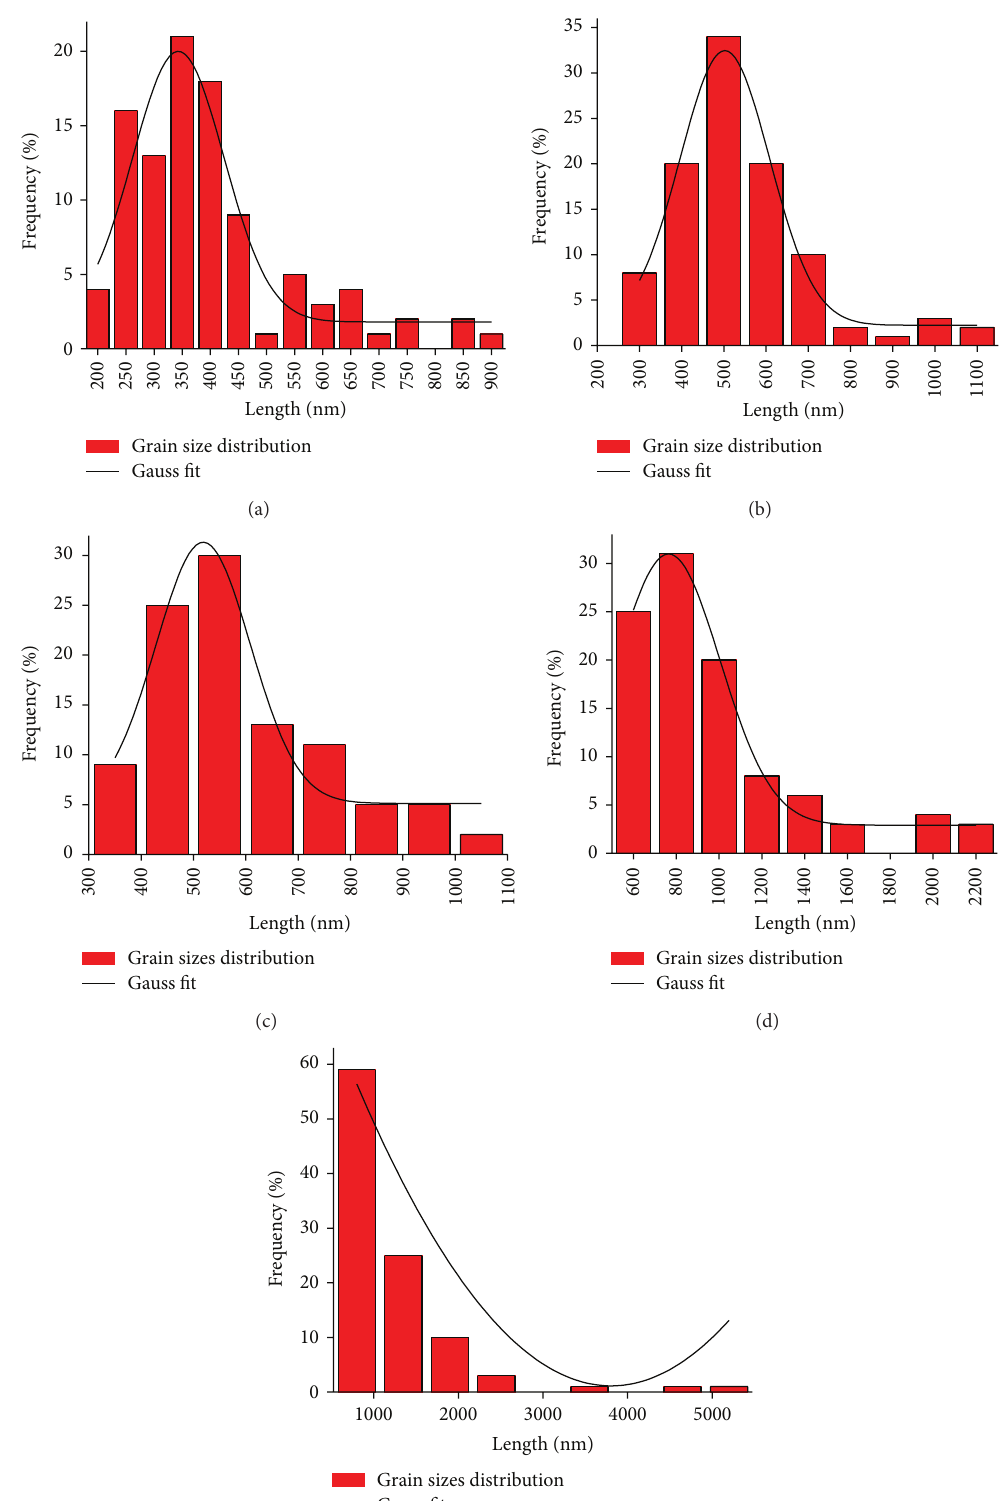
Figure 8: Grain size distribution of 3 wt% Eu 2 O 3 doped willemite samples sintered at (a) 600 ∘ C, (b) 700 ∘ C, (c) 800 ∘ C, (d) 900 ∘ C, and (e) 1000 ∘ C for